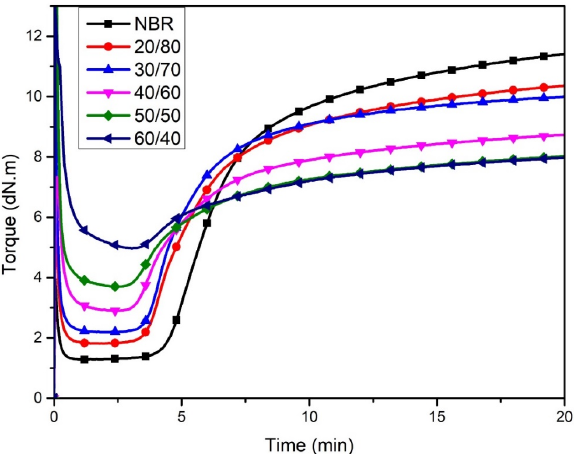
Figure 1. Rheograph of various WLF/NBR ratio. Table 2. Effect of WLF/NBR ratio on vulcanization and tensile properties.